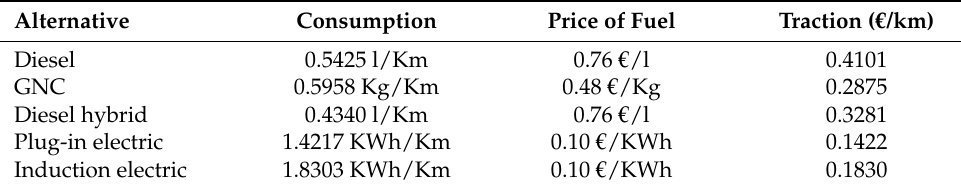
Table 9. Data for the analysis of traction costs, before taxes, by type of